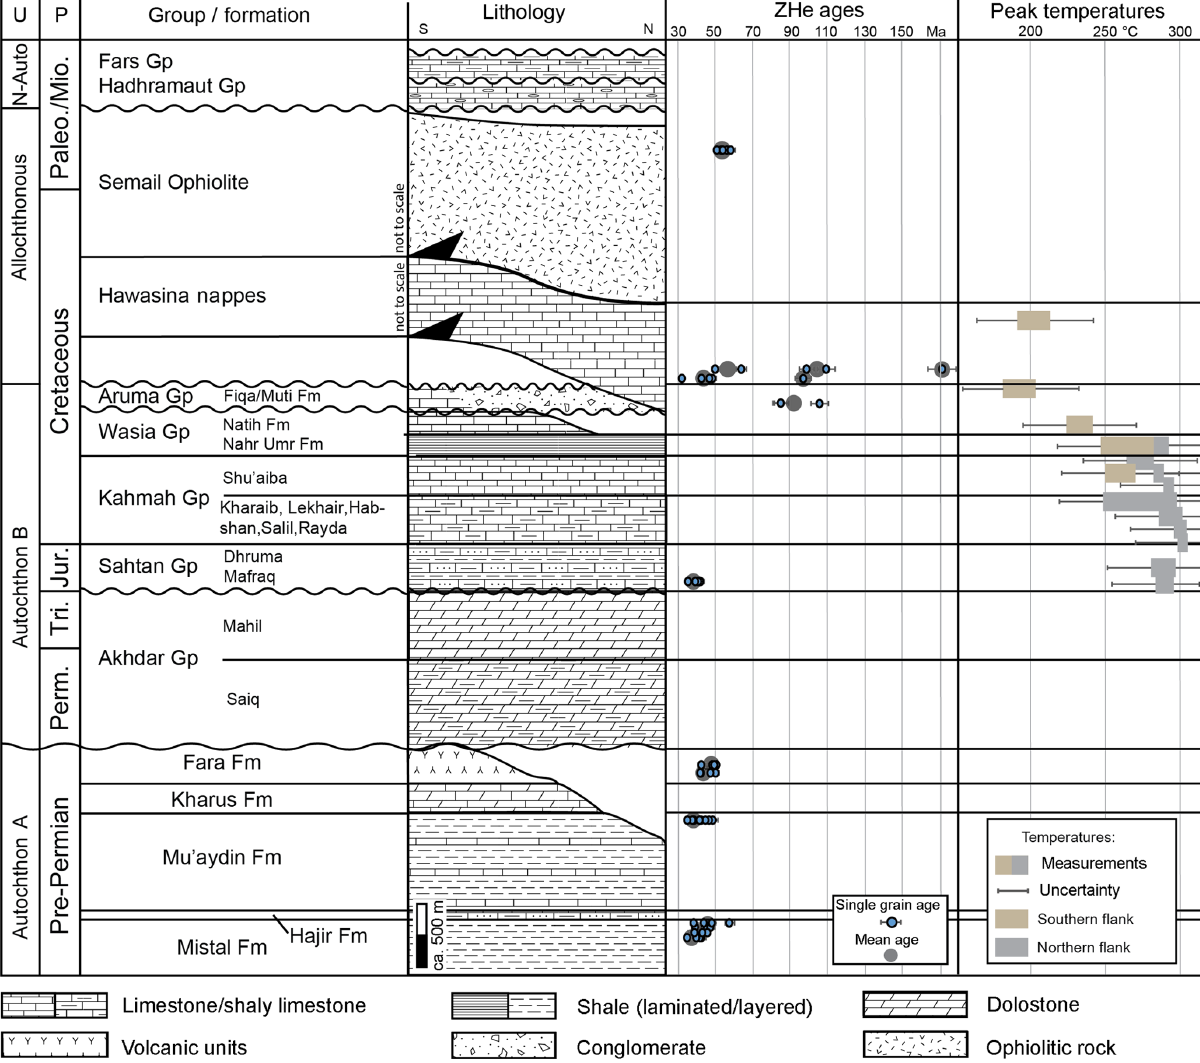
Figure 3. Stratigraphy of the Jebel Akhdar area with its two passive margin sequences Autochthon A and B overthrust by Hawasina and Semail nappes and unconformably overlain by neo-autochthonous units. Thermal calibration data are shown: ZHe ages (Table 2) show two different grain age clusters. Peak burial temperatures from organic matter maturity (Table 1) outline the temperature increase with stratigraphic age. Temperatures shown relate to the measurements and related uncertainties of the calculations (U: unit, P: period). Note that the Semail and Hawasina nappes are shown in their structural rather than stratigraphic positions; lithological data are compiled from Beurrier et al. (1986), Loosveld et al. (1996), Terken et al. (2001), and Forbes et al.